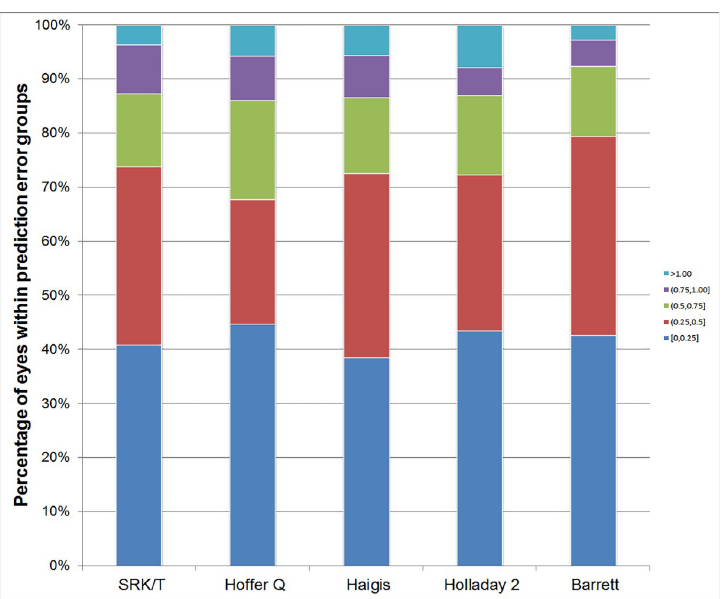
Fig 3. Stacked histogram comparing the percentage of cases within a given diopter range of predicted refraction outcome of the five intraocular lens (IOL) calculation formulas for the ZCB00 model.